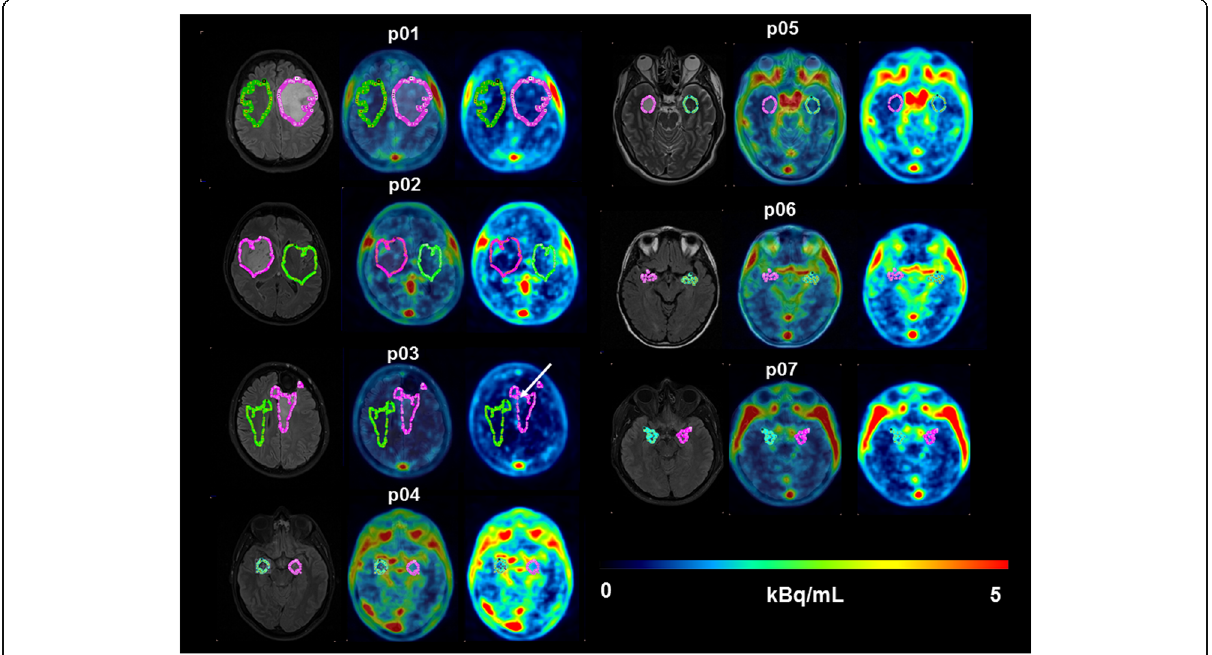
Fig. 1 Transversal T2-weighted FLAIR MR images (left image), co-registered PET/T2-weighted FLAIR MR images (middle image) and [ 11 C]tariquidar PET average images (0 – 60 min) (right image) in all patients. The contours for the tumor and contralateral tumor-free brain area are shown in pink and green colors, respectively. For p03, a tumor area with enhanced radioactivity uptake as compared with the rest of the tumor was visible (indicated by white